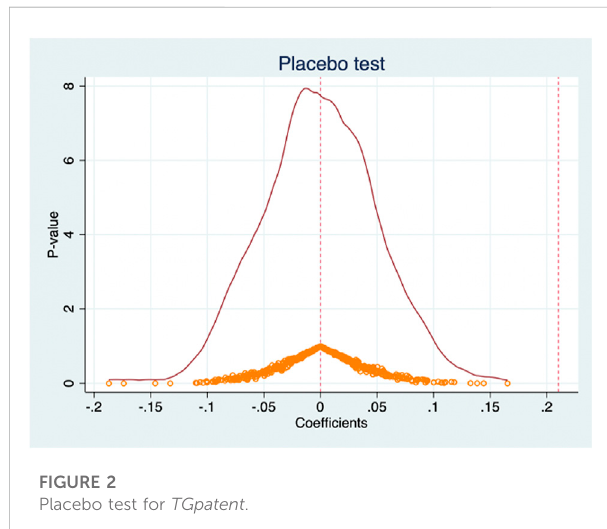
FIGURE 2 Placebo test for TGpatent